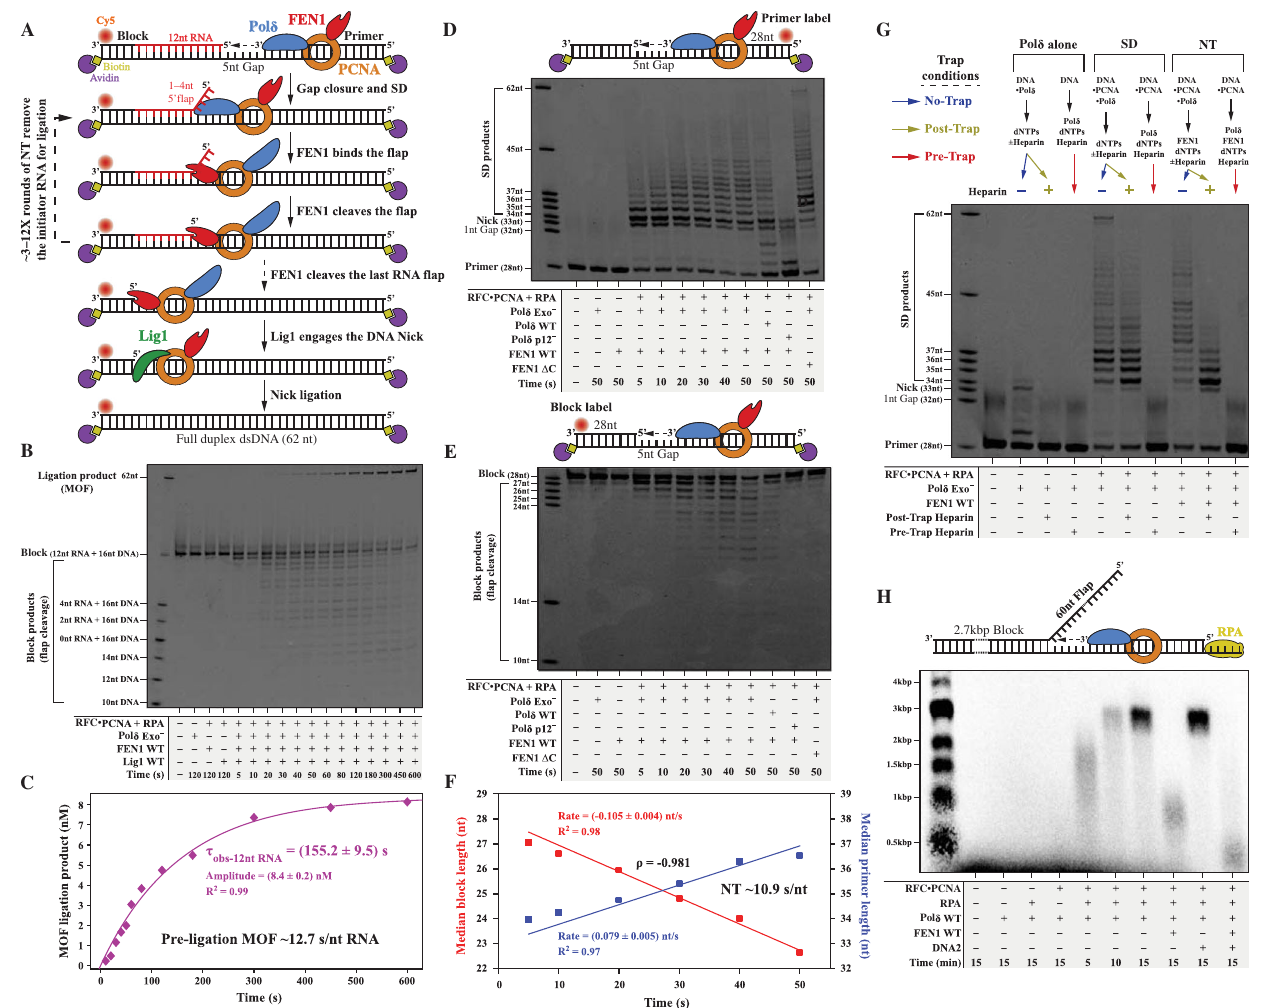
Fig. 1 | Reconstitution of the human MOF reaction. A Cartoon depiction of the maturation of Okazaki fragments (MOF) and nick translation (NT) reactions. B ReactionproductsforthereconstitutedhumanMOF:250nMPol δ ,250nMFEN1, 250nM Lig1, and DNA Sub#1 (Supplementary Fig. 7) at room temperature (RT). C Quanti fi cation of the time dependence of the ligated MOF product yield from panel B . The experimental datapoints were fi tted to a single-exponential product- formation burst equation ½ MOFLigatedProduct=Amplitude (cid:2) ð 1 (cid:3) e (cid:3) t = τ obs (cid:3) 12ntRNA Þ(cid:4) . The pre-ligation MOFprocessing time was calculatedby subtracting 3.3s (the time neededforthe fi nalligationstep;SupplementaryFig.1B)from τ obs (cid:3) 12ntRNA (155.2s) andthentheresultwasdividedby12nt(thelengthoftheRNAregionoftheblock). D , E NT products monitored through the extension of the primer oligonucleotide ( D ) or through the cleavage of the block oligonucleotide ( E ): 250nM Pol δ , 250nM FEN1, RT, DNA Sub#2, and Sub#3 (Supplementary Fig. 7). F Quanti fi cation of the reactionratespresentedinpanels D and E .Medianproductlengthsbeyondthe fi rst